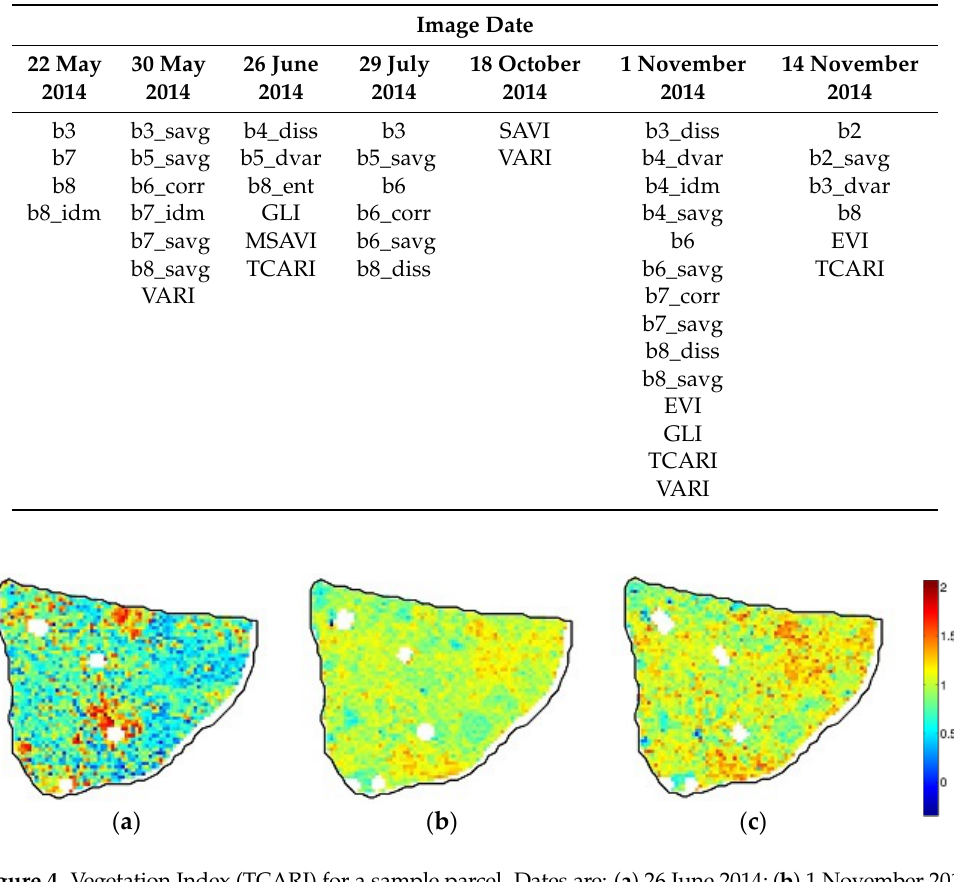
Figure 4. Vegetation Index (TCARI) for a sample parcel. Dates are: ( a ) 26 June 2014; ( b ) 1 November 2014; and ( c ) 14 November 2014.